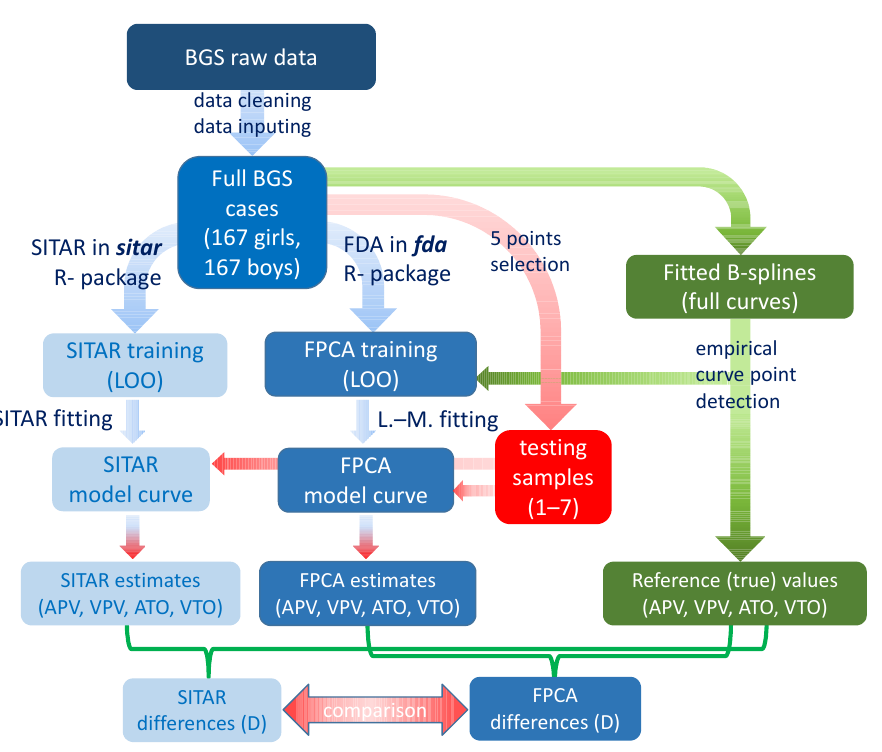
Figure 1. Scheme of the procedure of this research; BGS—Brno Growth Study, SITAR—a method based on superimposition by translation and rotation, FDA—Functional Data Analysis, FPCA— Functional Principal Component Analysis (FPCA), LOO—leave-one-out permutation procedure, L.-M.—Levenberg–Marquardt optimization algorithm, APV—age at peak velocity in puberty,